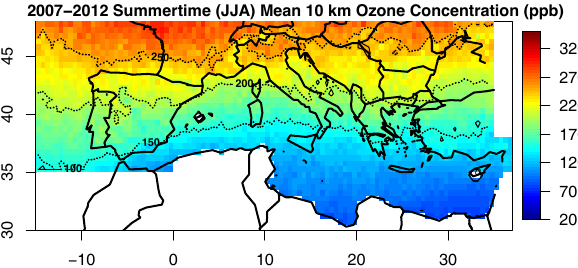
Figure 4. 2007–2012 summertime (June, July and August) average of 10km ozone (ppb) measured by IASI (morning overpasses).